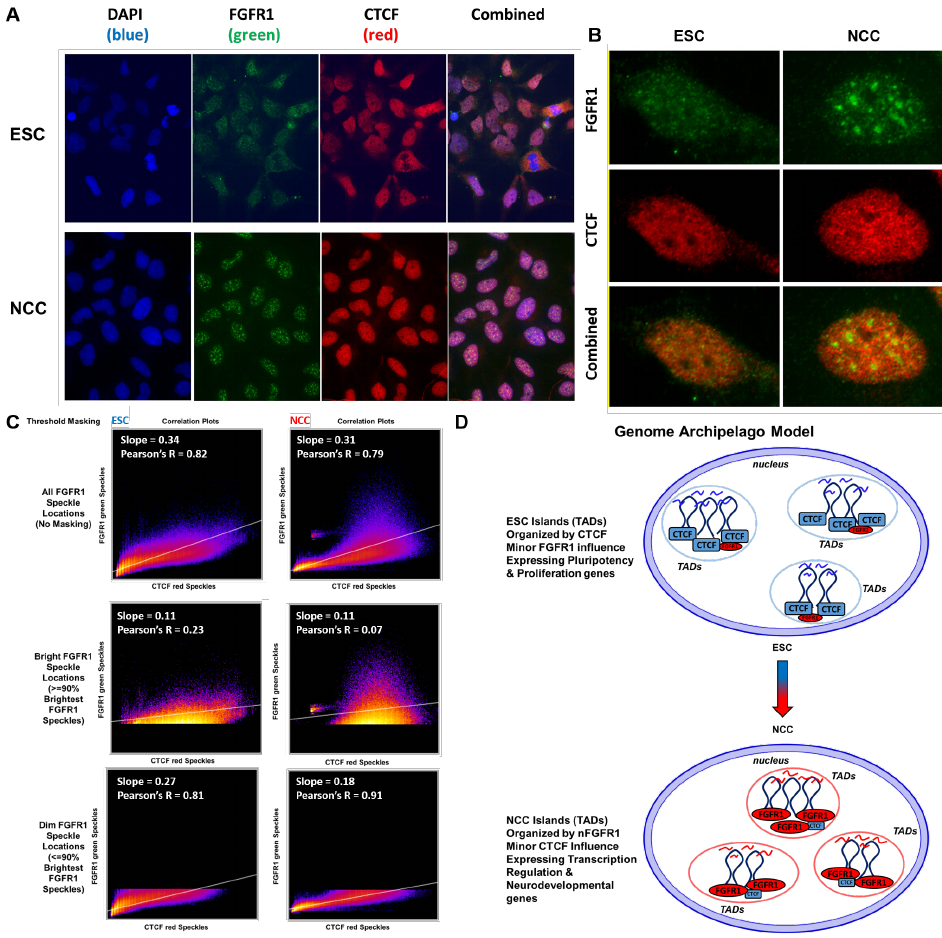
Figure 10. ESC nFGFR1 binding colocalizes with CTCF, NCC nFGFR1 binding targets new locations distinct from CTCF. ( A ) Immunocytochemistry of ESC and NCC stained with CTCF ab (red) and nFGFR1 ab (green). ( B ) Enhanced view of single ESC and NCC nuclei. ( C ) Correlation analysis of CTCF and nFGFR1 colocalization using Fiji ImageJ Coloc 2. ( D ) Genome Archipelago Model-hubs of transcriptional activity occur throughout the genome as TAD and multi-TAD islands.